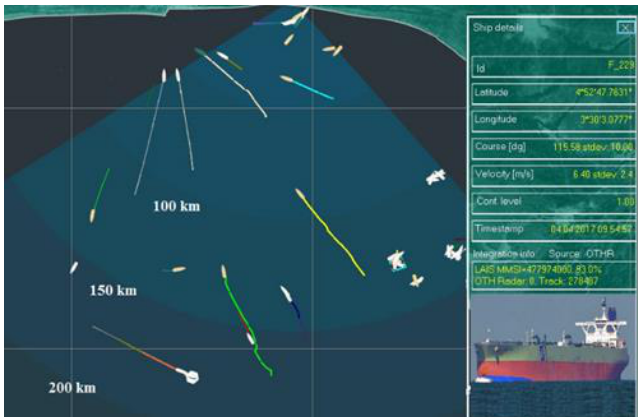
Figure 13. HFSWR detection capabilities during bad weather conditions over part of the HFSWR surveillance area and HFSWR sites.